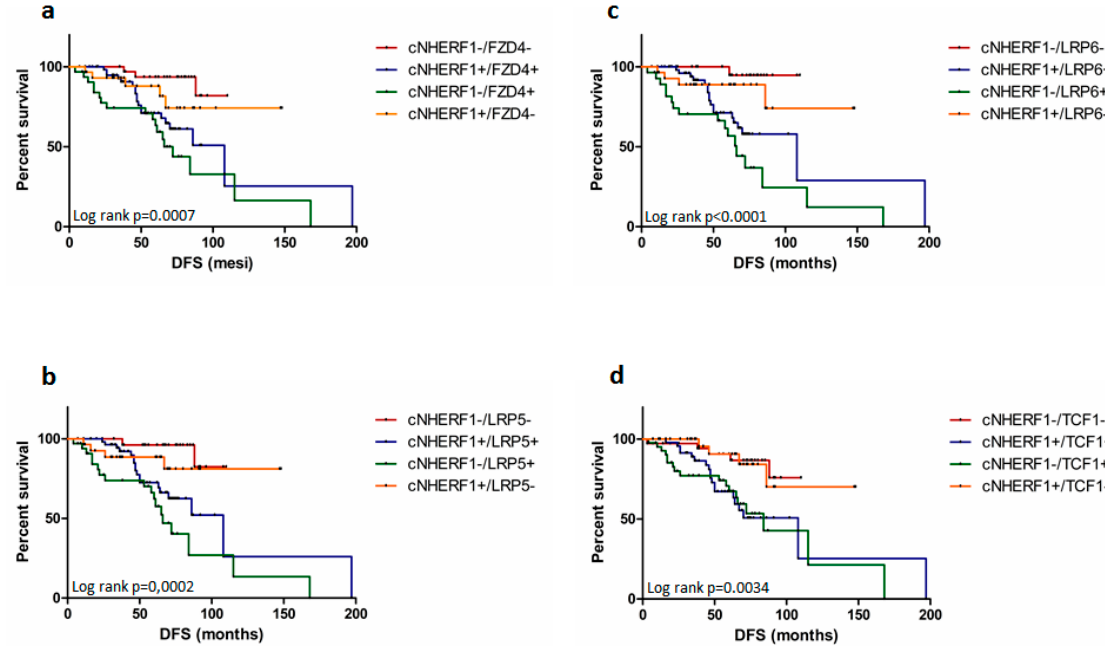
Figure 3. Survival analyses, according to both (Na+/H+ Exchanger Regulatory Factor 1) NHERF1 and Wnt/pathway proteins co-expression. Disease-free survival (DFS) curves for patients with ( a ) cNHERF1/FZD4 (Frizzled receptor 4) co-expression, four subgroups were compared: cNHERF1 − /FZD4 − , cNHERF1+/FZD4+, cNHERF1 − /FZD4+, and cNHERF1+/FZD4 − with a p = 0.0007; ( b ) cNHERF1/LRP5 (Low-density lipoprotein receptor-related protein LRP) co-expression, four subgroups were compared: cNHERF1 − /LRP5-, cNHERF1+/LRP5+, cNHERF1 − /LRP5+, and